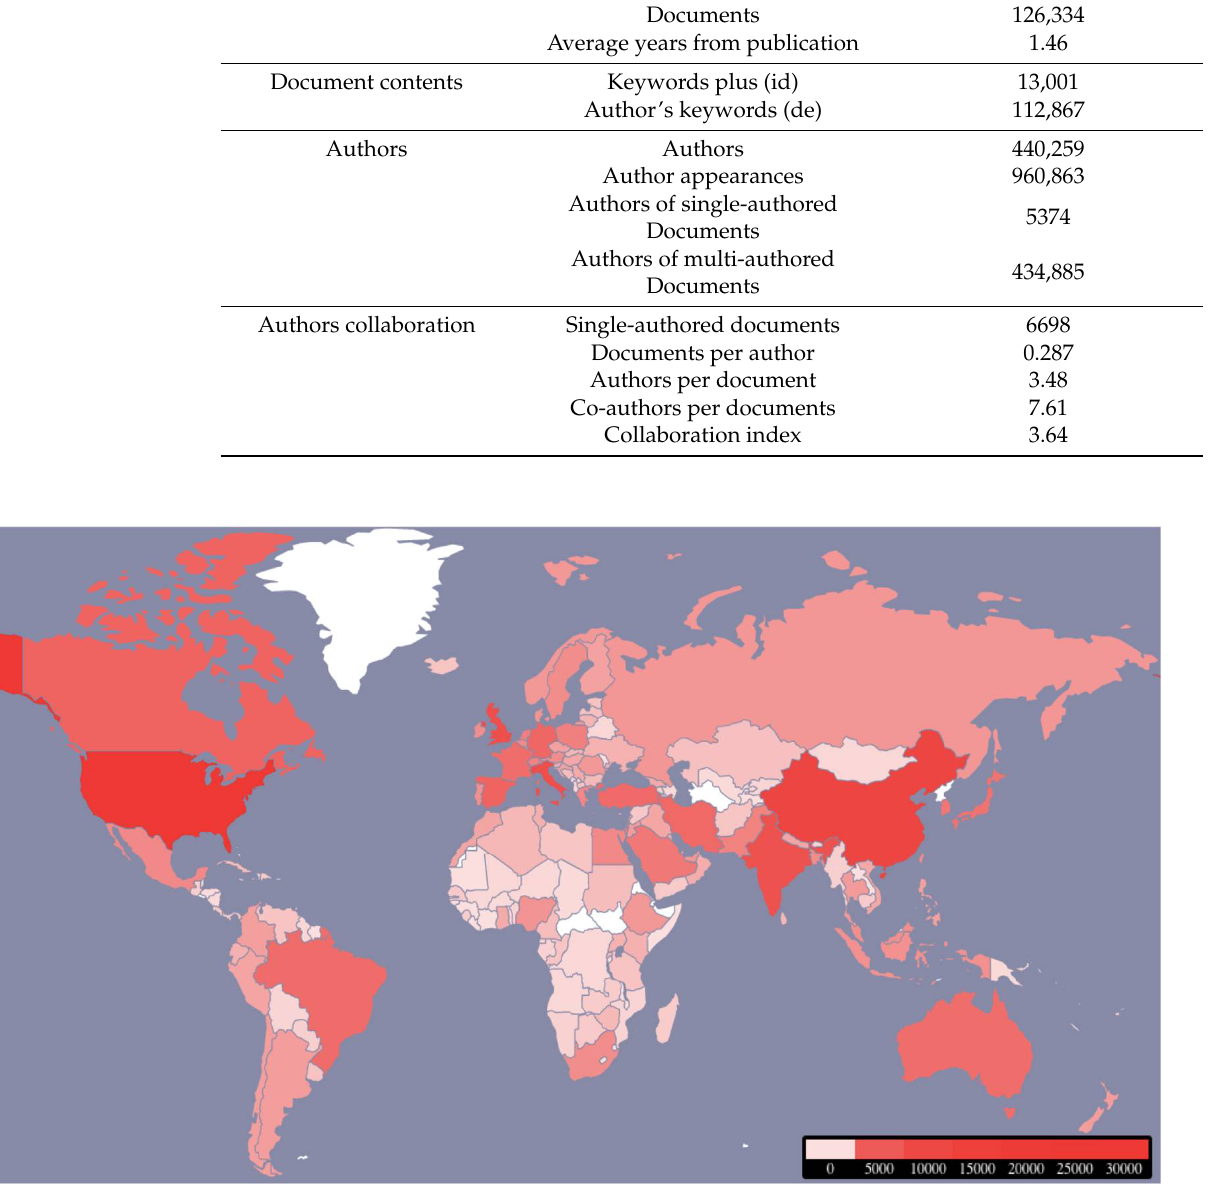
Table 2. Main statistics about the COVID-19 collection.